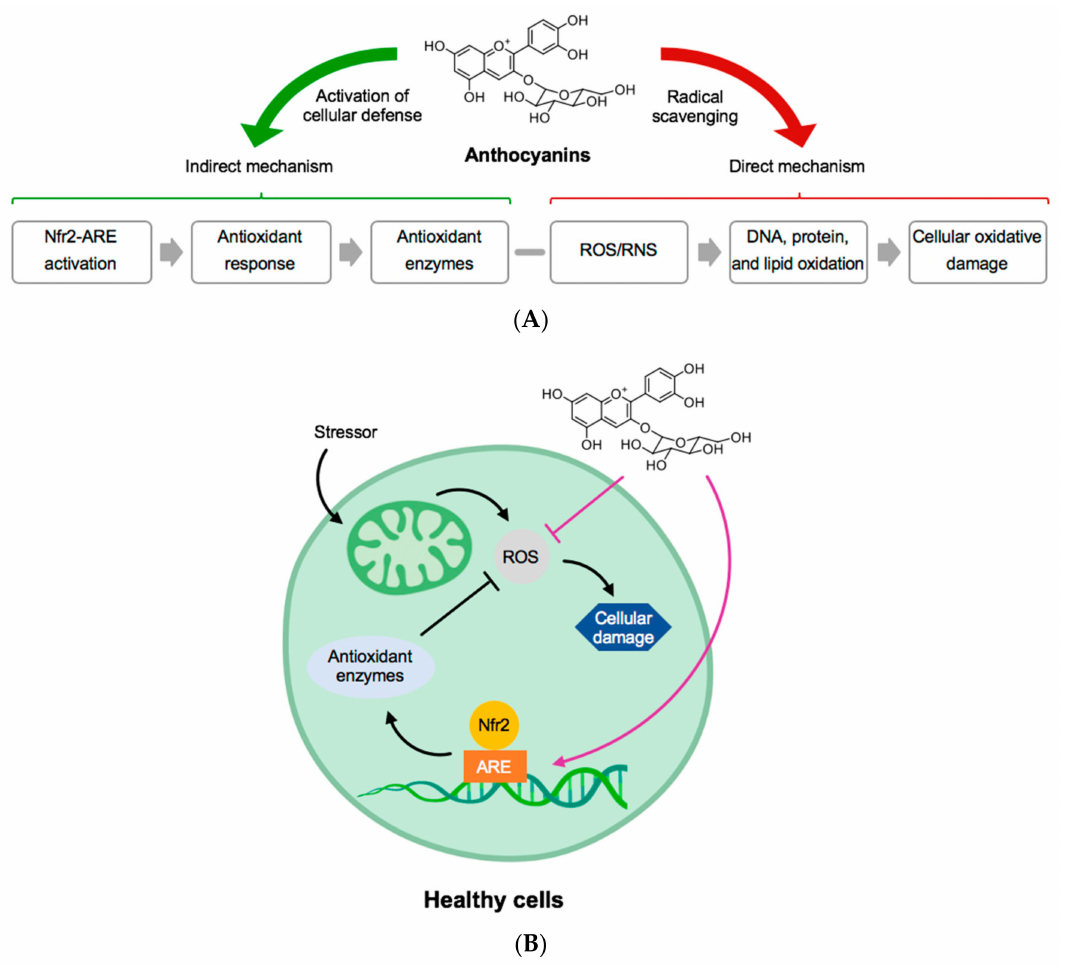
Figure 2. ( A ) General structure of anthocyanins and their mechanism of direct and indirect activation of antioxidant protection. ( B ) In a healthy cell, an example of how anthocyanins can block reactive oxygen species (ROS) and protect the mechanism for production of antioxidant enzymes. Abbreviations: ARE, Antioxidant response element; Nfr2, NF-E2-realted factor-2; RNS, reactive nitrogen species. Adapted from